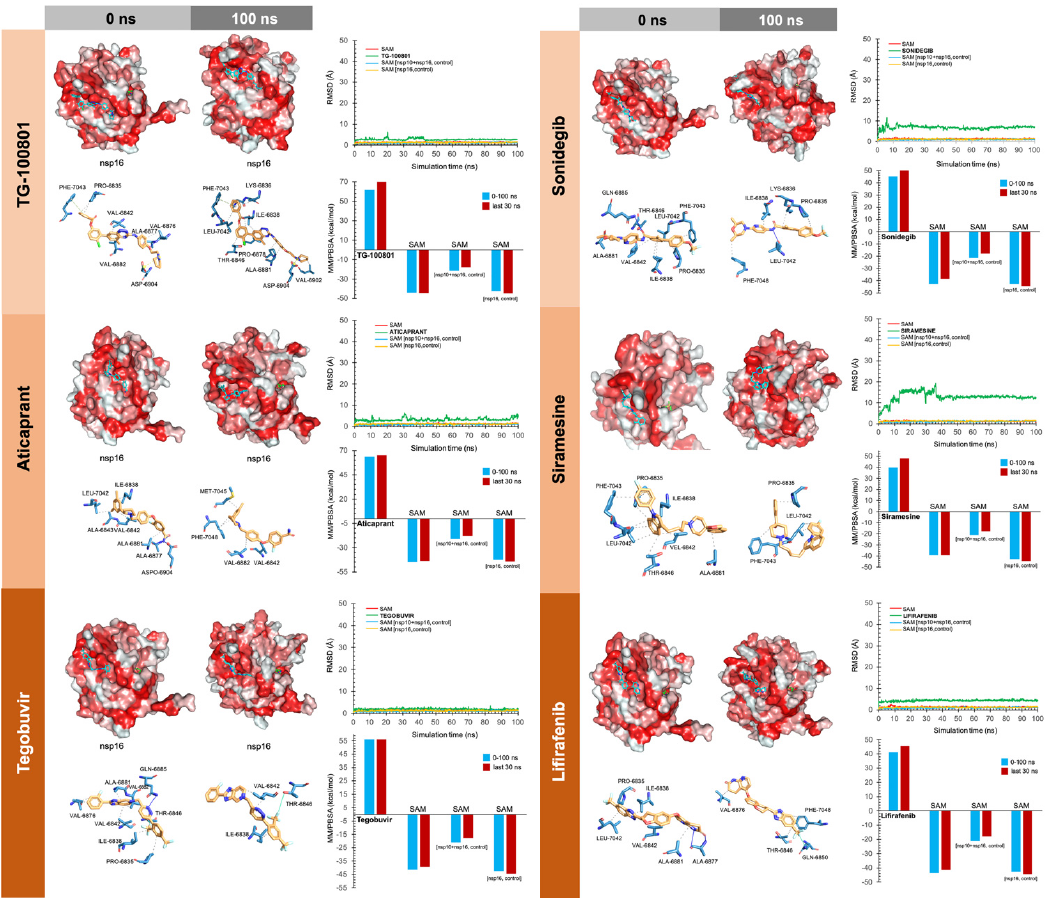
Figure 4. Incorporation models of the predicted nsp16-activating-surface-targeting drugs in SARS- CoV-2 2 ′ -O-MTAse. The best poses of the predicted candidates coupled to the nsp16 activating surface before (0 ns) and after (100 ns) the molecular dynamics (MD) simulation are shown. The protein has been represented as a function of the hydrophobicity of its surface amino acids and the Na + and Cl − ions have been eliminated to facilitate visualization. Each inset shows the detailed interactions of each drug candidate docked to the nsp16 activating surface, indicating the participating amino acids involved in the interaction and the type of interaction (hydrogen bonds, hydrophilic interactions, salt bridges, Π -stacking, etc). The root mean square deviation (RMSD, Å) of each drug’s heavy atoms over the simulation time, measured after superposing the protein on its reference structure, is shown. In the context of the MD presented here, the RMSD incorporates traces of SAM alone and in two additional control simulations (i.e., nsp16/nsp10 complex and nsp16 alone).